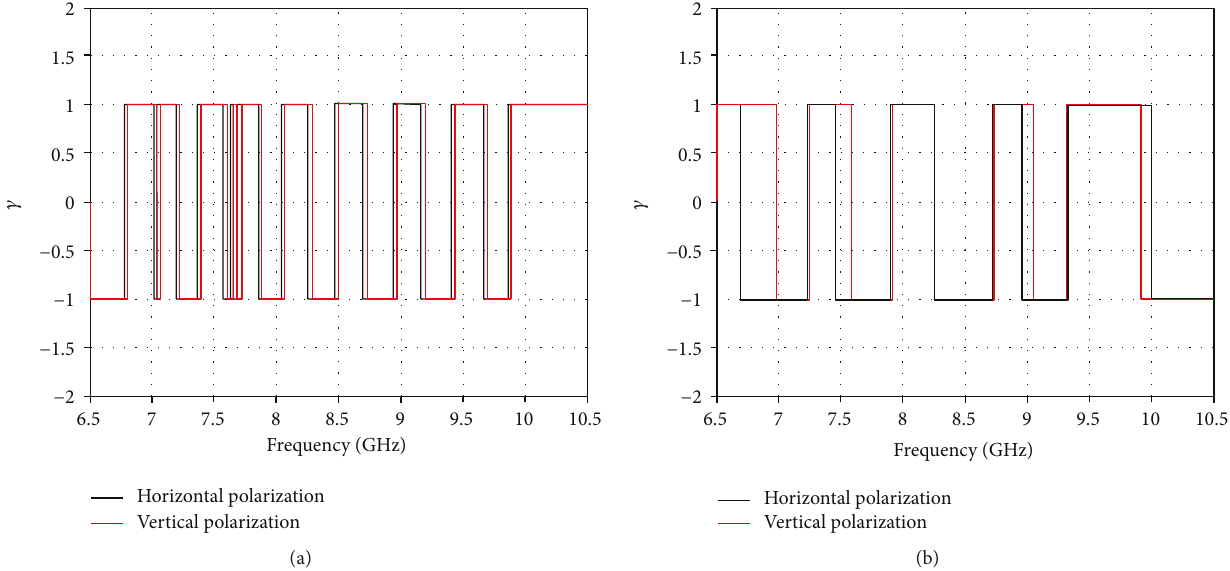
Figure 8: The output of the polarity correlator for the horizontal and vertical components of codes 111111111 and 010101010,